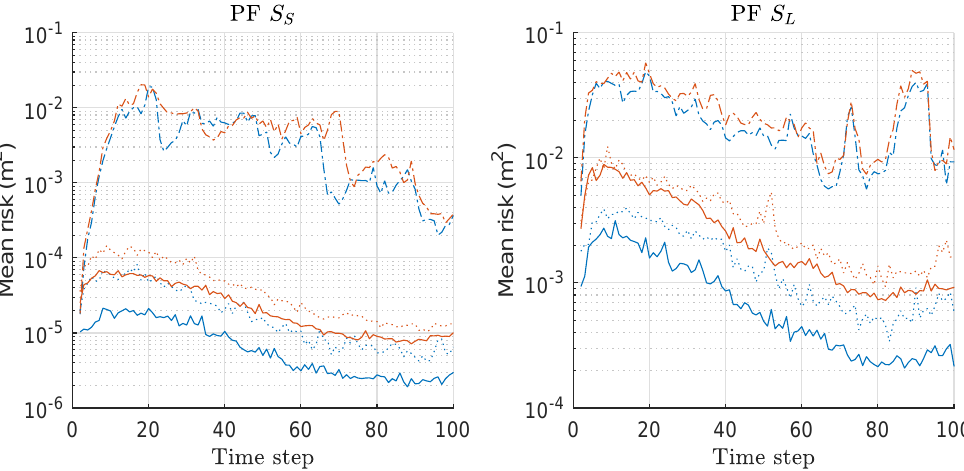
Figure 2. Mean-risk over 300 runs with 1000 particles based on Equation (20) for PF and MPF. Results regarding only r x are shown, and those regarding r y showed similar results. Legend: line style (dash-dot: M = 2; dotted: M = 5; solid: M = 10); (line color: blue: PF; red: